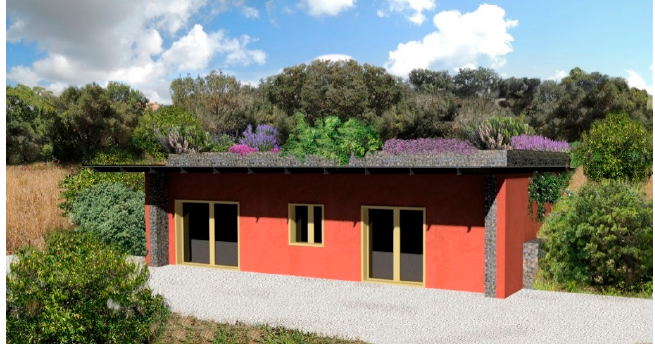
Figure 4. Rendering of the agricultural sustainable building. Buildings 2016 , 6 , 17